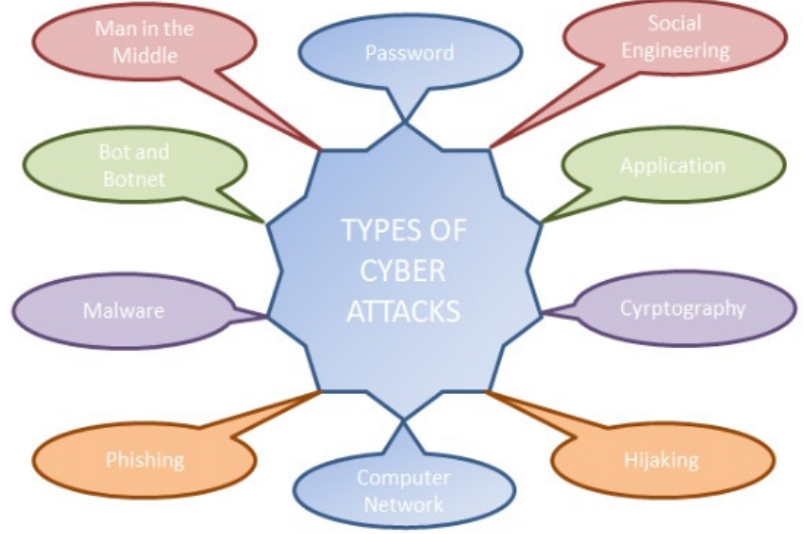
Figure 5. Common types of attacks.